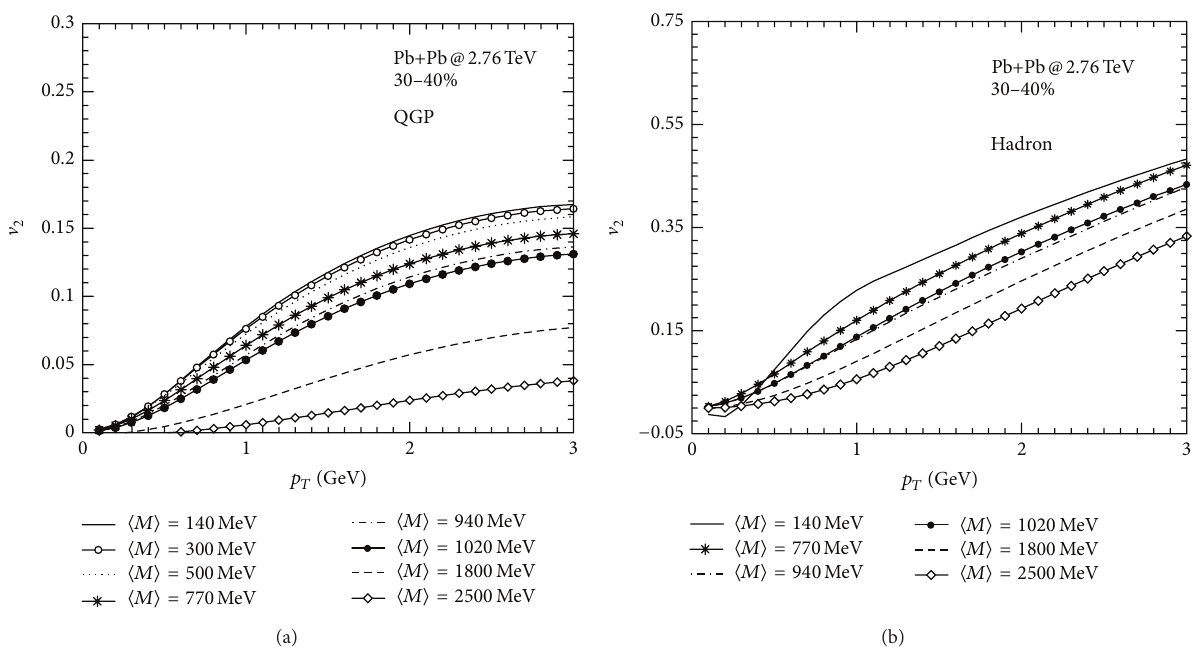
Figure 40: Elliptic flow of quark matter (a) and hadronic matter (b) as a function of 𝑝 𝑇 for various mass windows.